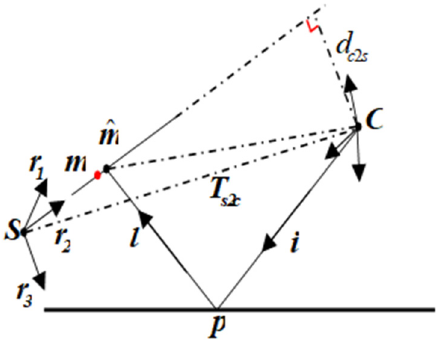
Figure 4. Principle of back projection. The rotation matrix R s 2 c can be written as ( r 1 r 2 r 3 ) . r 3 denotes the unit vector in the Z -axis of the reference plane. T s 2 c denotes the distance between S and C . The reflected ray l intersects the reference plane at the point ˆ m . The point ˆ m satisfies − r 3 T · ˆ m = d s 2 c . We denote by d c 2 s the distance between C and the reference plane.